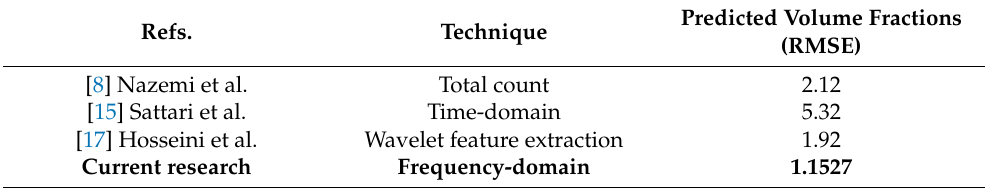
Table 4. A comparison between error ratios. Refs.